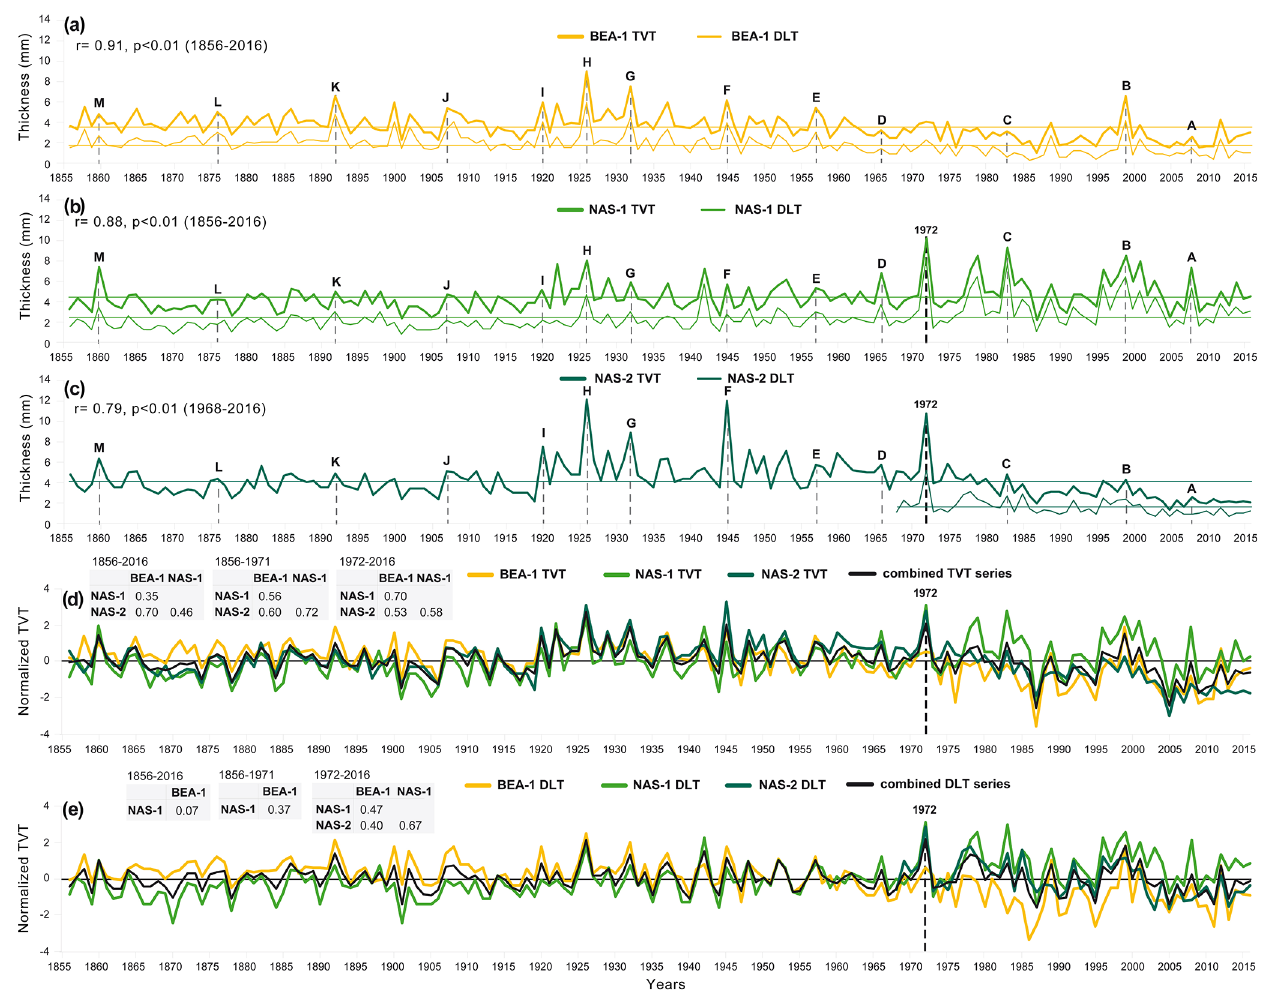
Figure 6. Total varve thickness (TVT; thick line) and detrital layer thickness (DLT; thin line) time series of cores (a) BEA-1, (b) NAS-1 and (c) NAS-2. Normalized (d) TVT and (e) DLT series and the combined series (mean of the normalized data from the three sites). Pearson correlation coefficients between TVT and DLT for the 1856–2016, 1856–1971 and 1972–2016 periods are shown. The selected marker layers are identified by the letters A to M, and the 1972 marker layer is outlined by the thick black dashed